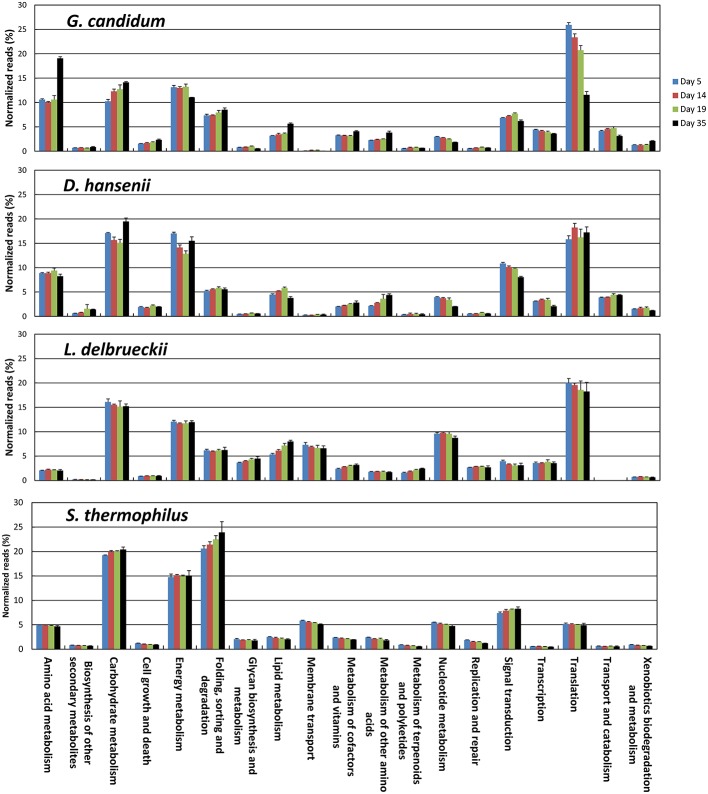
Functional classification of the transcriptomes of S. thermophilus, L. delbrueckii, D. hansenii, and G. candidum in the cheese rinds. The functional classes were determined according to KEGG annotations of the CDSs. The number of reads was represented as a percentage of the total reads of the species with KEGG assignments at each of the four sampling days, and the upper error bars represent the standard deviations (three cheese replicates).